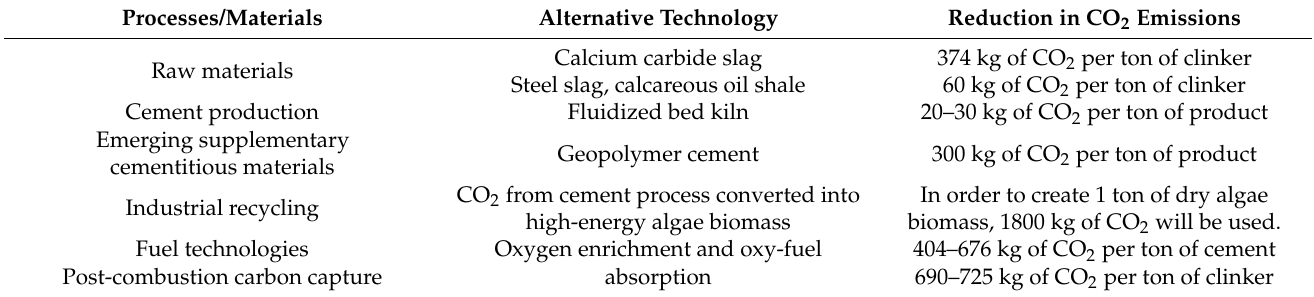
Table 1. Summary of how using alternative technology/materials in cement manufacturing results in lower CO 2